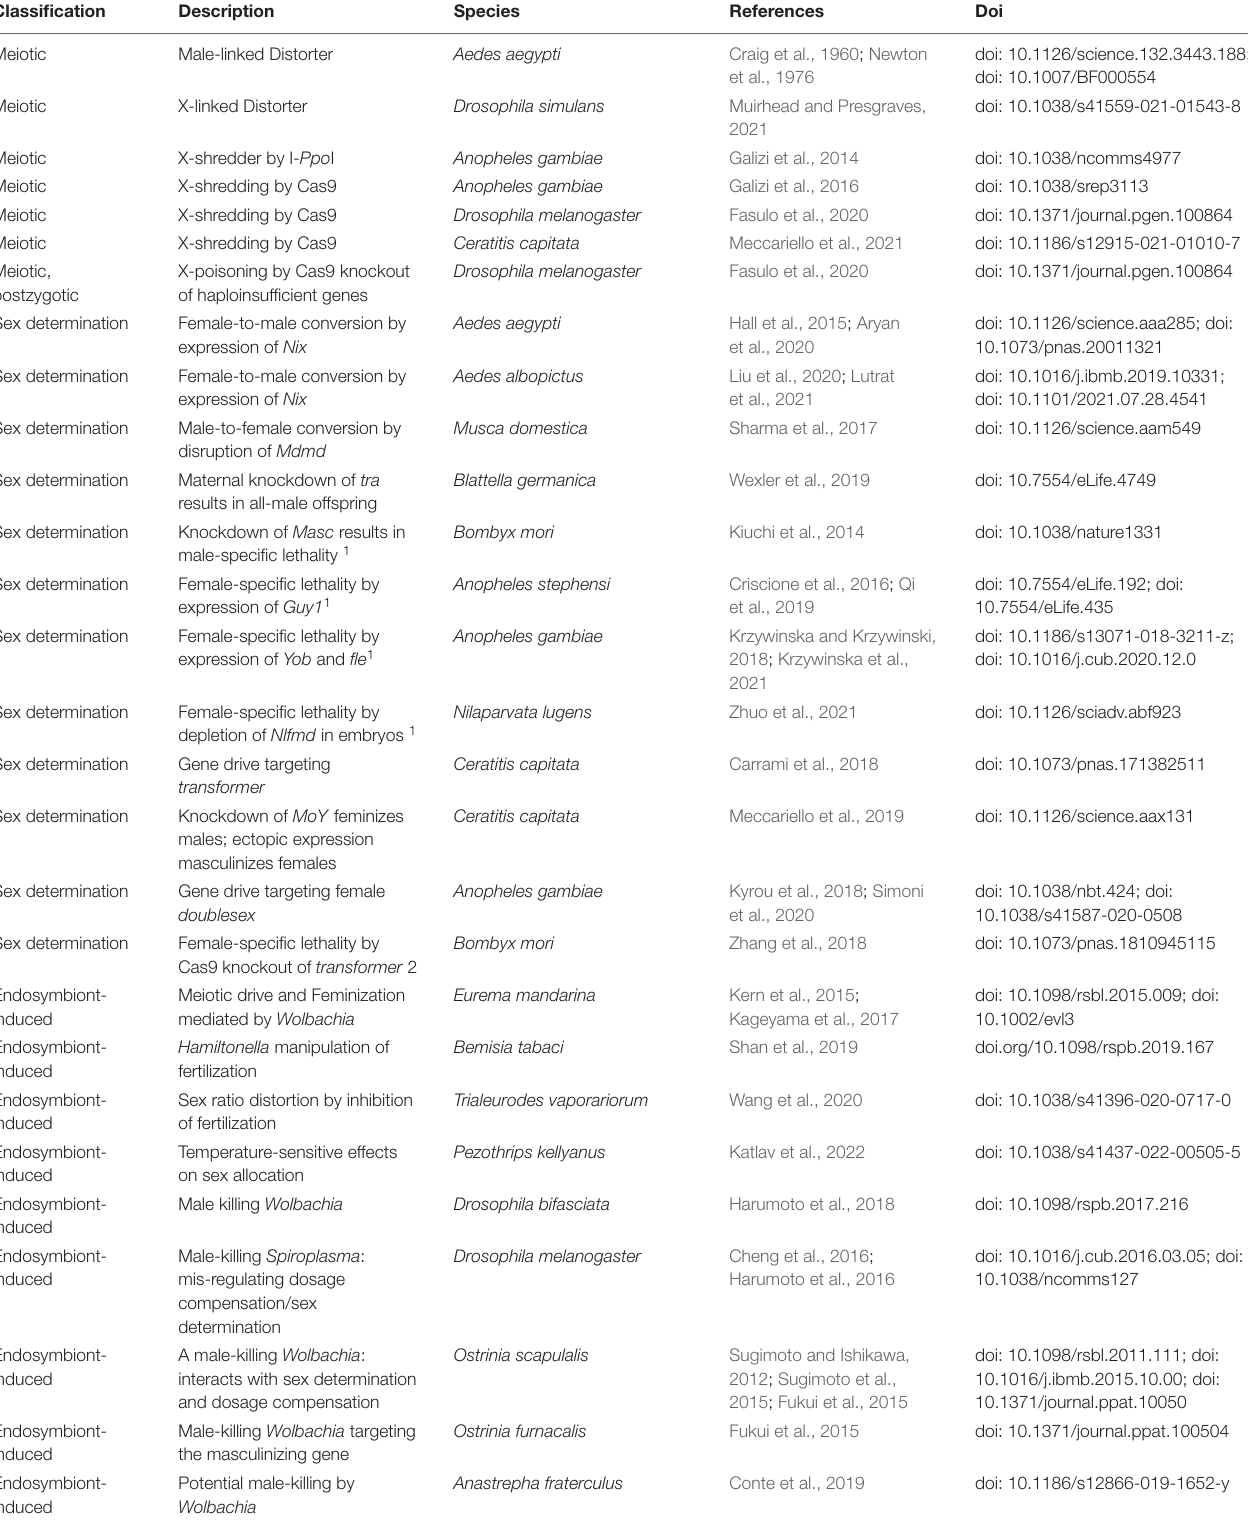
TABLE 1 | Examples of natural and engineered sex ratio